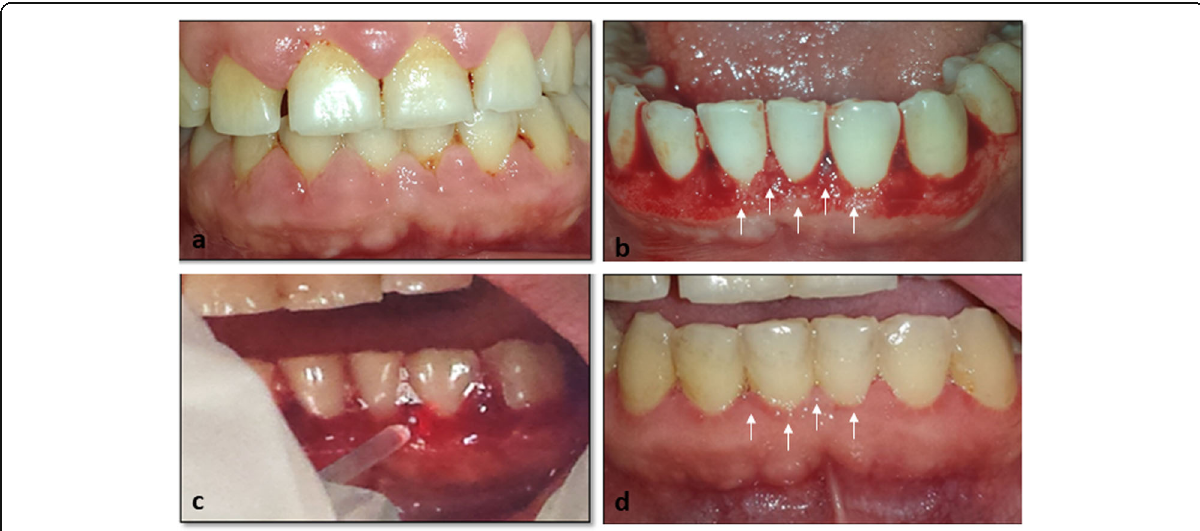
Fig. 1 Clinical view of gingival enlargement in mandibular incisors area indicated for gingivectomy (test group). a Before gingivectomy procedure. b Immediately after gingivectomy (white arrows). c Application of low-level laser therapy (LLLT) to the surgical site. d Gingival healing 2 weeks post-surgery. Note the change in gingival contour after surgery (white arrows in b ) and 2 weeks later (swhite arrows in d